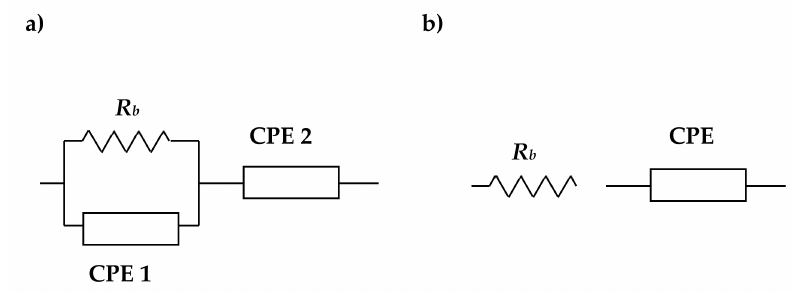
Figure 7. Equivalent circuit for ( a ) the semicircle-spike plot and ( b ) spike